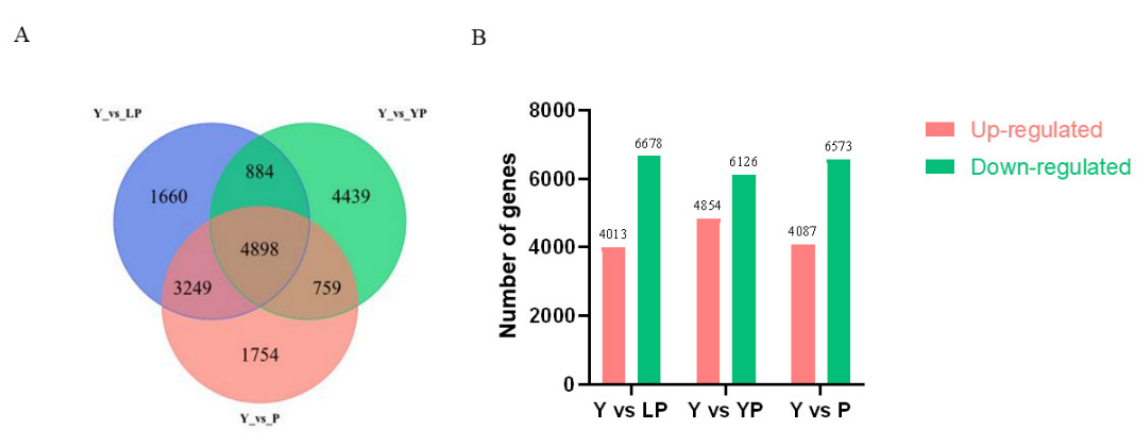
Figure 6. The DEGs between differently colored petals. ( A ) The upregulated and downregulated DEGs in different petal color groups. ( B ) Venn diagram of the upregulated DEGs between different petals color groups. Red bars indicate highly expressed genes, and green indicates less expressed genes.